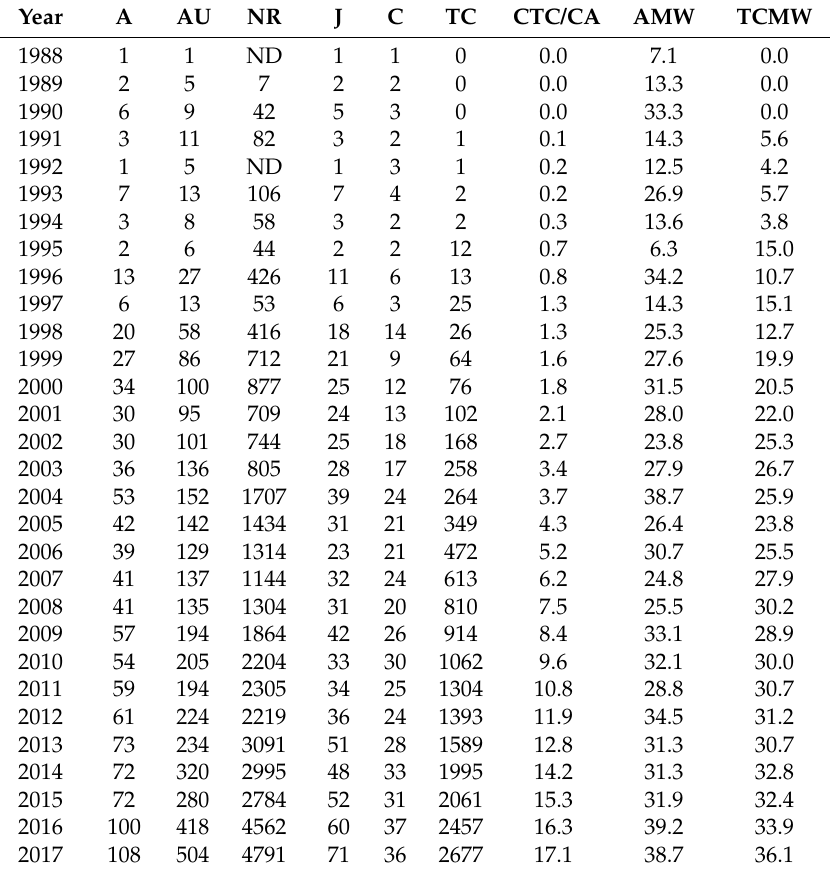
Table 8. Major characteristics of the articles published on